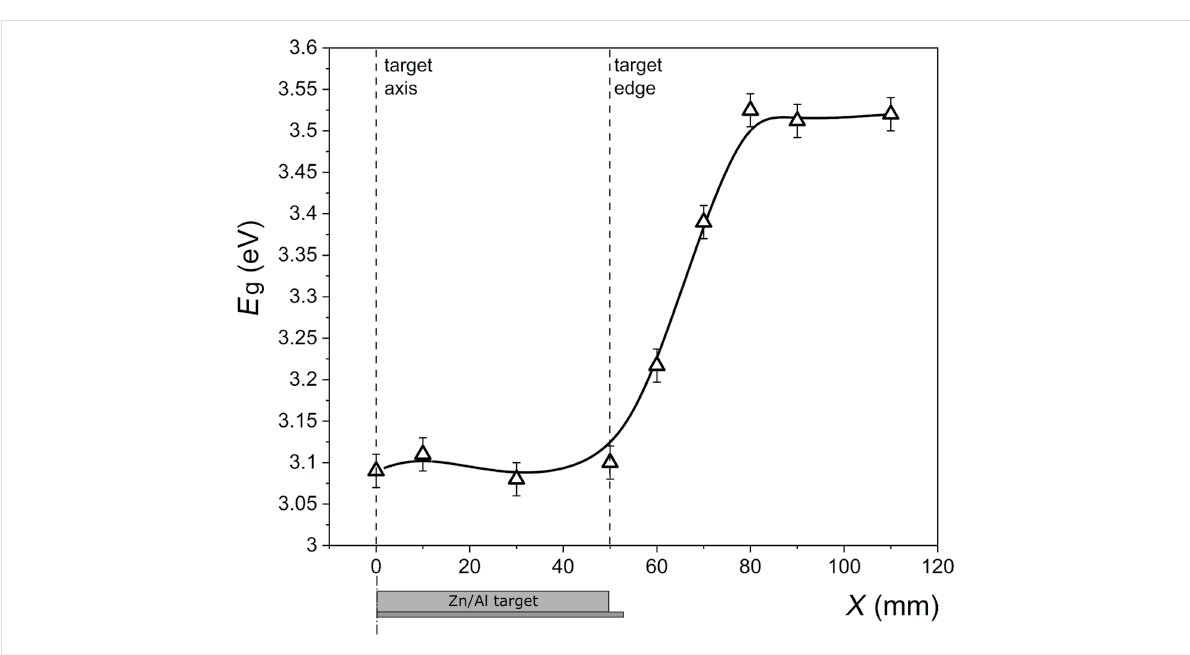
Figure 8: Results of the optical bandgap width estimated from optical measurements for thin films deposited at the front side of the substrate as a function of the distance X from the Zn/Al target axis. The line is to guide the eye.